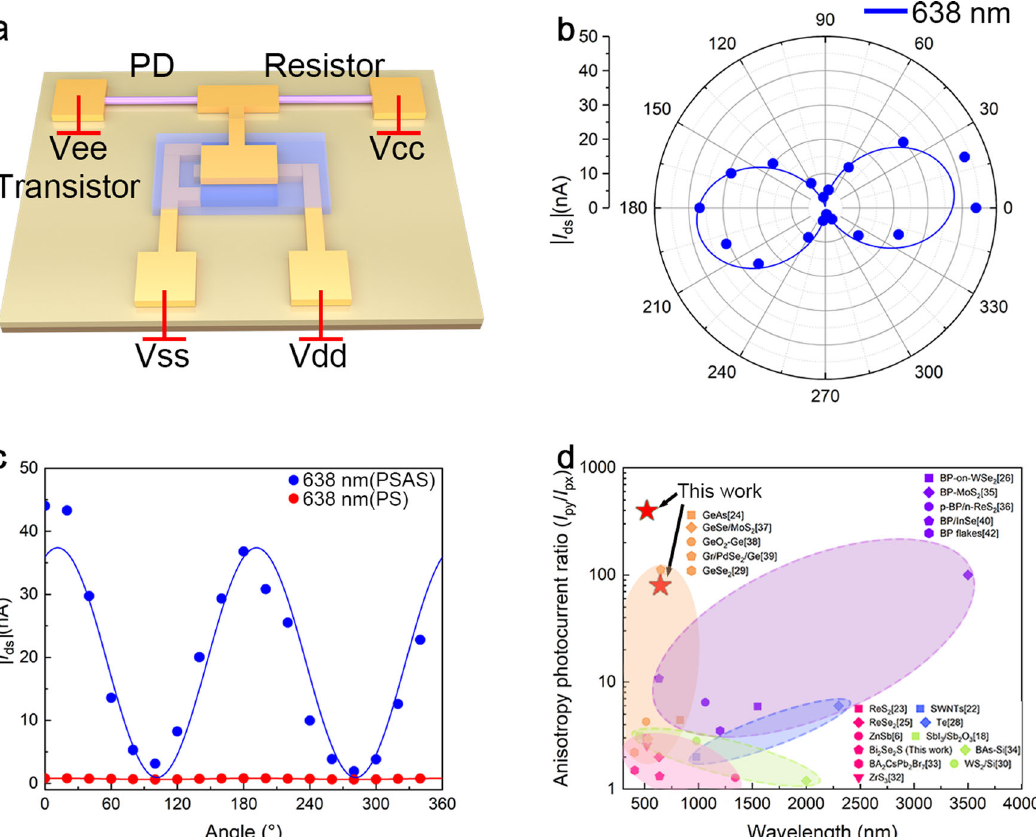
Fig. 3 The polarized optoelectronic properties of PSAS. a Structure schematic diagram of PSAS including Bi 2 Se 2 S NWs based PS and reference resistor, the C 8 -BTBT/PS-based OFET. b Polar plot of the relationship between photocurrent and polarization angle under 638 nm (optical power density of 113.579mW/cm 2 ) at V dd = − 0.5 V and V cc = + 4.5 V. Circles and curves represent experimental data and the result of the formula fi tting. c Rectangle coordinate of the relationship between photocurrent and polarization angle of PSAS and PS-based Bi 2 Se 2 S NWs respectively under 638 nm. d Comparison of the anisotropic photocurrent ratio of our work and previous research